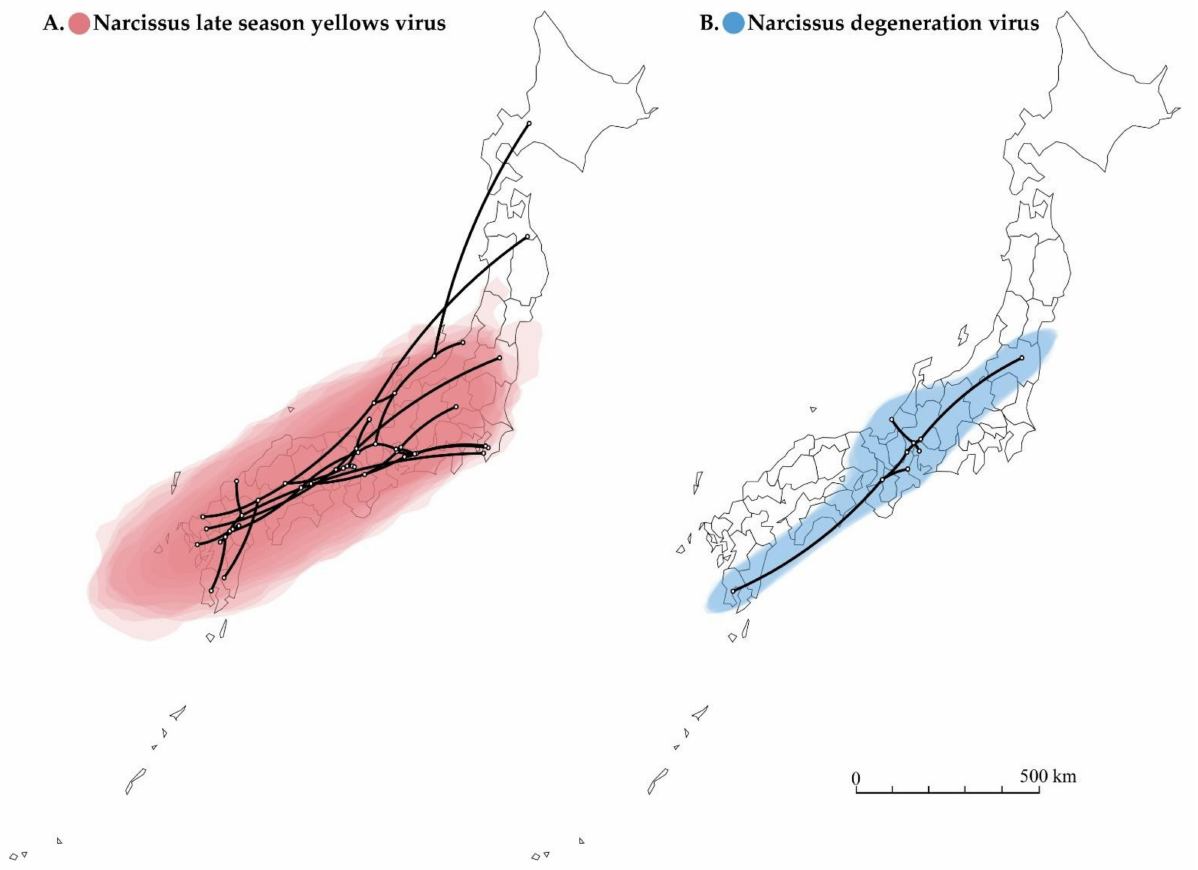
Figure 5. Spatial diffusion of narcissus viruses. ( A ) Twenty-five partial polyprotein coding sequences (genome position nt 2076–7471) of narcissus late season yellows virus (NLSYV). ( B ) Five complete polyprotein coding sequences of narcissus degeneration virus (NDV) were used. The points indi- cate the location of ancestral internal nodes and external tips. The 95% areas of credible intervals based on 1000 trees subsampled from the post-burn-in posterior distribution are shown as colored shadows. The map was obtained from https://gist.github.com/minikomi/4043986 (accessed on 10 January